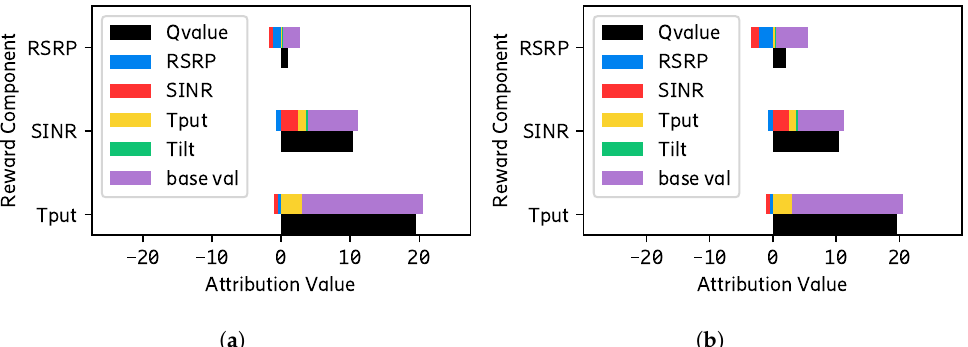
Figure 9. Complete explanation where the sum of feature attribution and base values equals the predicted Q-values. ( a ) Attribution and Q-values at the Q-level. ( b ) Attribution and Q-values on RL